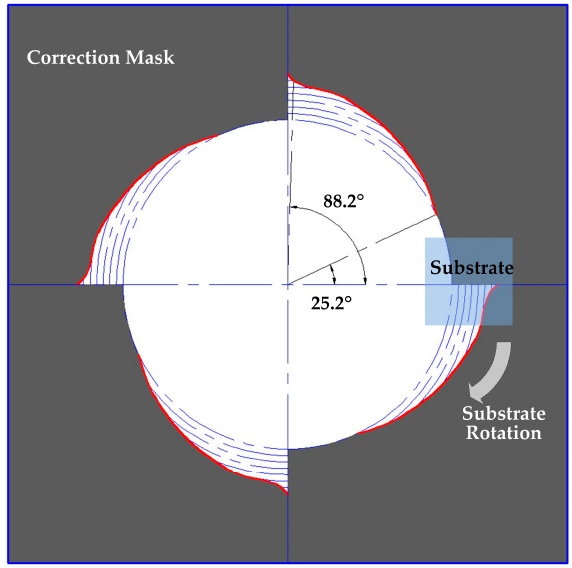
Figure 3. Schematic diagram of correction mask .